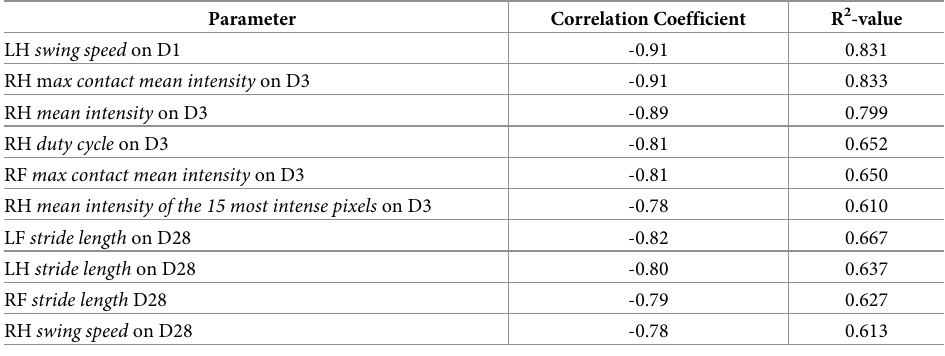
Table 2. Overview of all R 2 -values above 0.6.